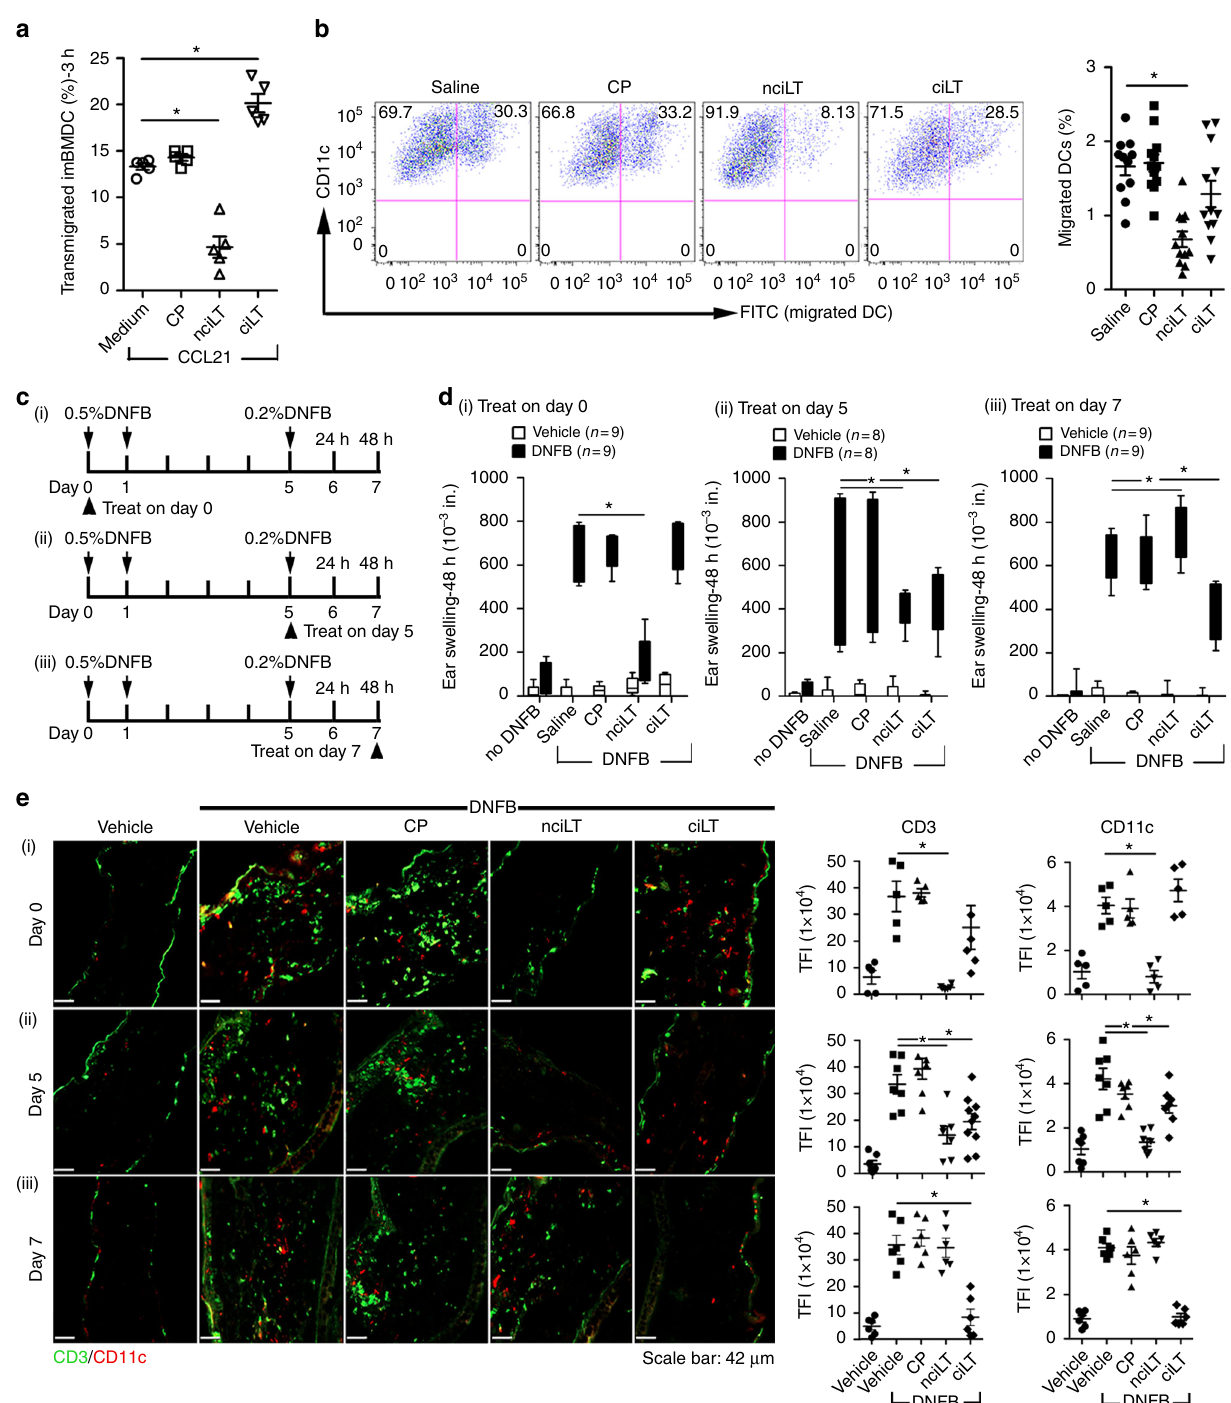
Fig. 7 Inhibition of LT β R signaling alters CHS and leukocyte migration. a In vitro DC migration to CCL21 (50 ng/mL) through LEC treated with the indicated peptides (20 μ M). b In vivo DC migration assay. i.d. injection of the indicated peptides (20 nmol) to the shaved abdomen, followed 30 min later by FITC painting. After 16 h, inguinal and axillary LNs collected and analyzed with fl ow cytometry. c Experimental design schematic. 20 nmol of indicated peptides injected i.d. in the abdomen (100 μ L, day 0) or 10 nmol in each ear (30 μ L, day 5 or day 7) 30 min before DNFB painting on days 0 or 5. d , e CHS analyzed by ear swelling measured 48 h after DNFB challenge ( d ), or immunohistochemistry for CD11c + DC and CD3 + T cells ( e ). Magni fi cation ×20; scale bar 42 μ m. TFI total fl uorescence intensity. Representative of three independent experiments with 3 mice/group. * p < 0.05 by one-way ANOVA which caused fi rm adhesion of T cells on LEC, further showing crosstalk between the two arms of LT β R – NF κ B pathways, such that non-classical and classical NF κ B signaling interacted to that nciLT or ciLT decoy peptides in fl uenced TRAF3 or TRAF2 regulated LEC function. In contrast, the classical NF κ B-blocking recruitment to the receptor. Together these data demonstrated peptide ciLT enhanced CCL21 production in LEC and promoted major roles for LT β R related NF κ B pathways in regulating LEC T cell migration. Molecular interactions indicated upstream function and TEM. NATURE COMMUNICATIONS| (2018) 9:3020 |DOI: